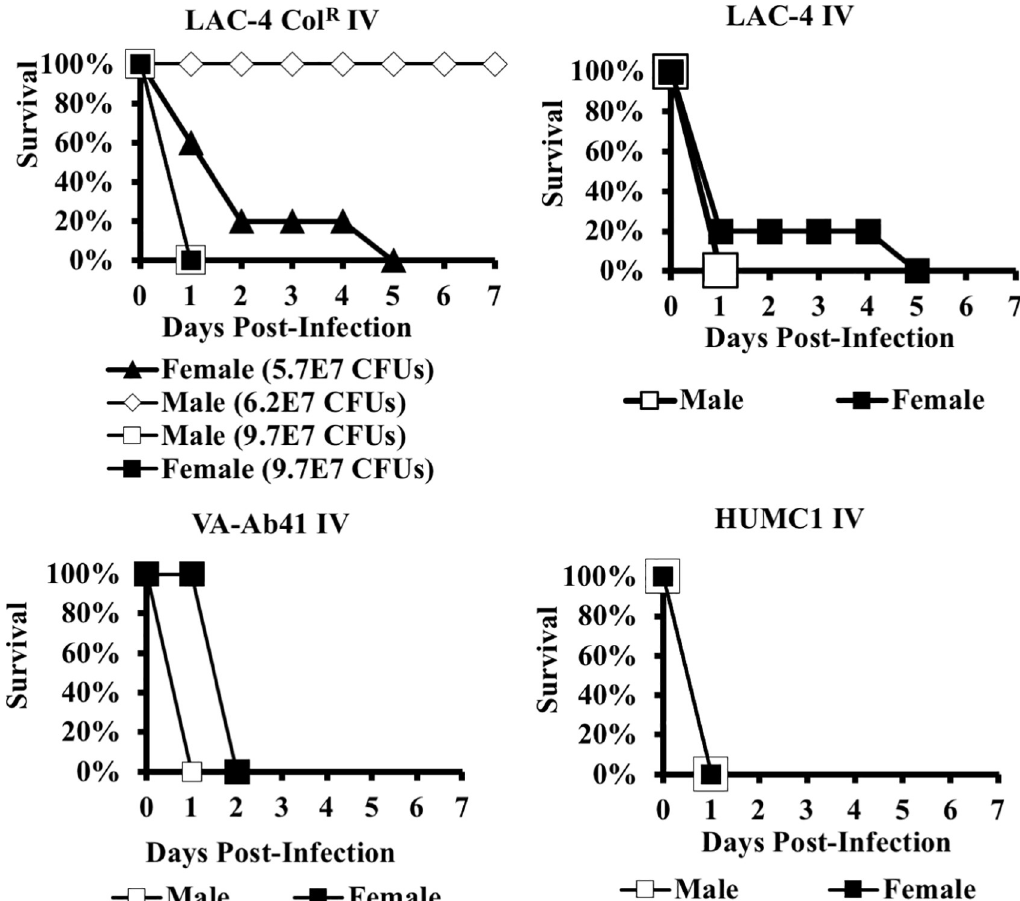
Fig 1. The effect of gender on mouse susceptibility, blood infection model. Mice were infected with the LD100 inoculum listed in Table 1 unless otherwise specified. Variation in host susceptibility by gender was not consistently observed across all strains or infection routes. In the blood infection model, a gender effect (female mice were more sensitive as compared to males) was only observed with mice infected with LAC-4 Col R .